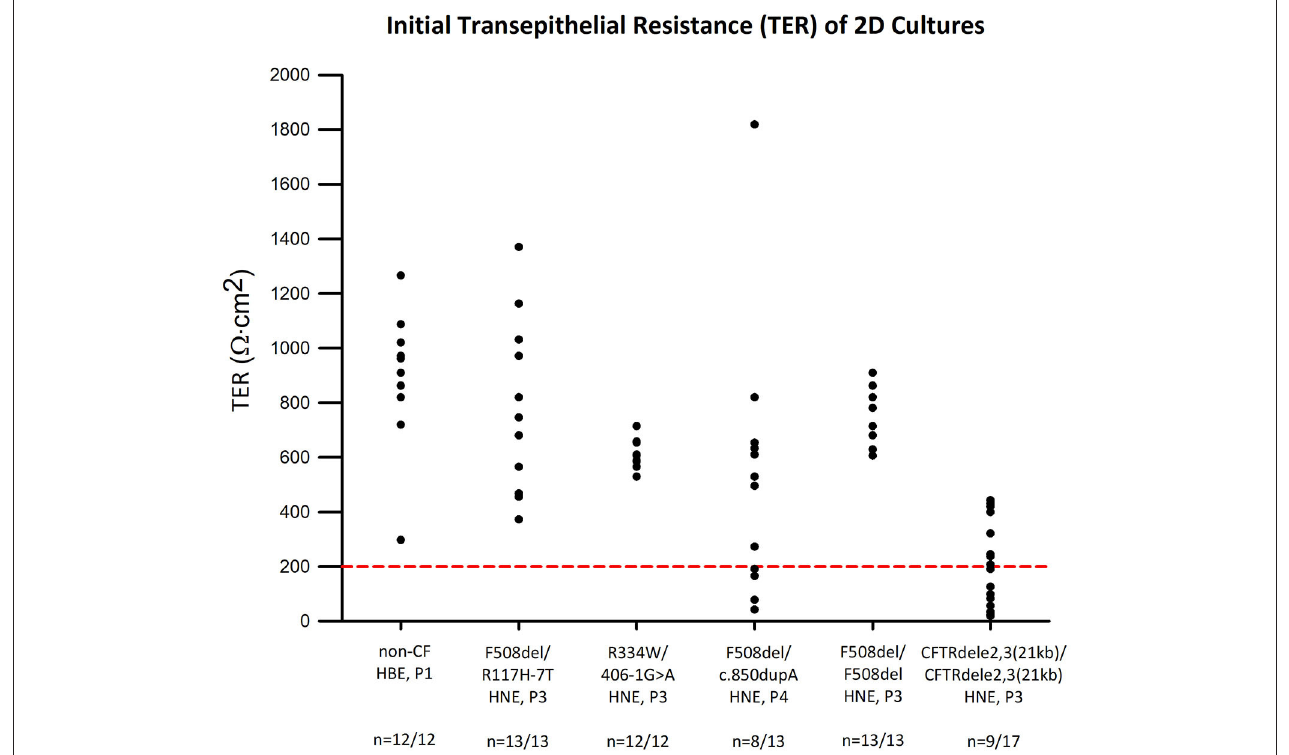
FIGURE 3 | Transepithelial electrical resistance (TER) of CF and non-CF airway cultures. TER values were obtained at the beginning of the Ussing chamber experiment and plotted for each genotype. Red line represents quality control standard set at 200 (cid:127) cm 2 . Except for F508del/c.850dupA cells ( n = 8 of 13) and CFTRdele2,3(21kb) homozygous cells ( n = 9 of 17), all other cultures meet the standard and are viable for subsequent analysis.